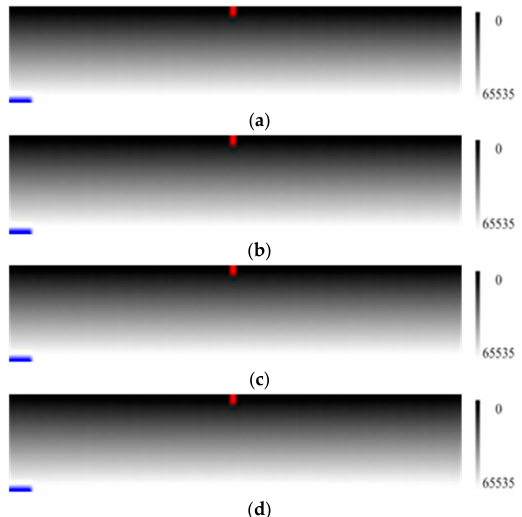
Figure 15. The relative calibration results of the verification image with gain coefficient and offset coefficient calculated from various grouping cases, where the horizontal direction is pixels and vertical direction is radiance level. ( a ) the result with coefficient from three groups case; ( b ) the result with coefficient from four groups case; ( c ) the result with coefficient from 500 groups case; and ( d ) the result with coefficient from 3000 groups case. Column 50 and line 20 are marked with red and blue labels, respectively.